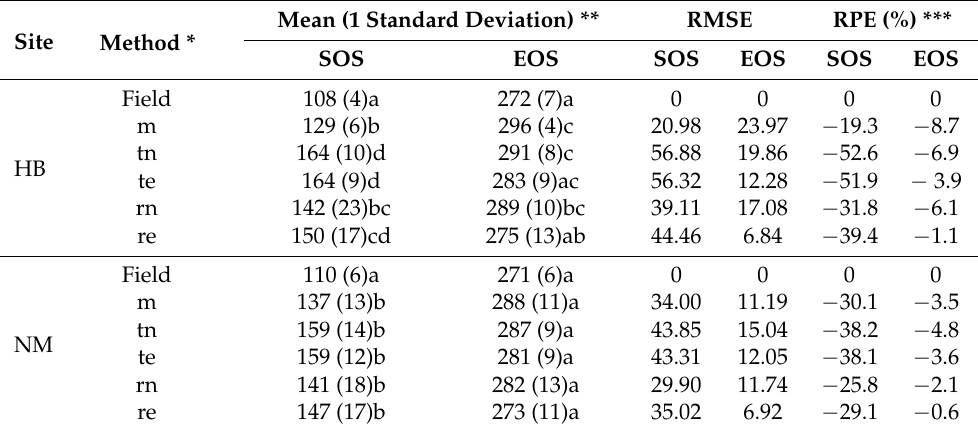
* Field, m, tn, te, rn, and re represent phenology measurements on the ground, MODIS phenology product (m), phenological products derived from NDVI and EVI using the threshold method (tn and te), and the relative